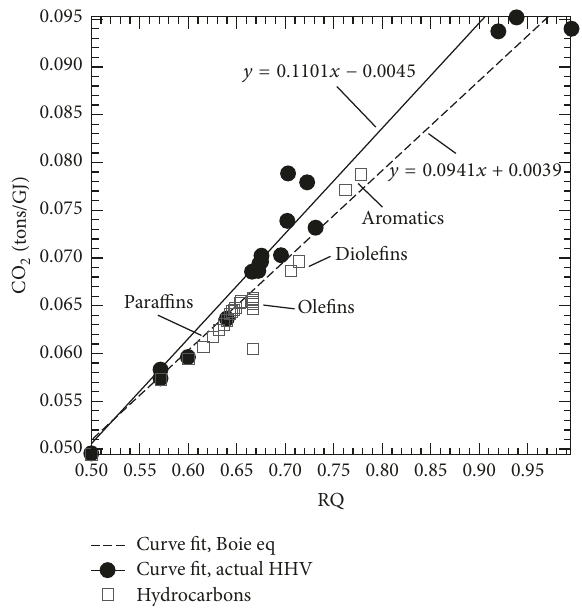
Curve fit, Boie eq Curve fit, actual HHV Figure 3: CO 2 emitted in tons per GJ of energy input for fuels with different RQ factors. Fuel measured heating value and composition data were used to estimate CO 2 released (for fuels listed in Table 2). Slope of both the trend lines (actual heating value and heating value estimated using Boie equation) was approximately 0.1 [13]. 𝑦 = CO 2 in tons per GJ, 𝑥 =